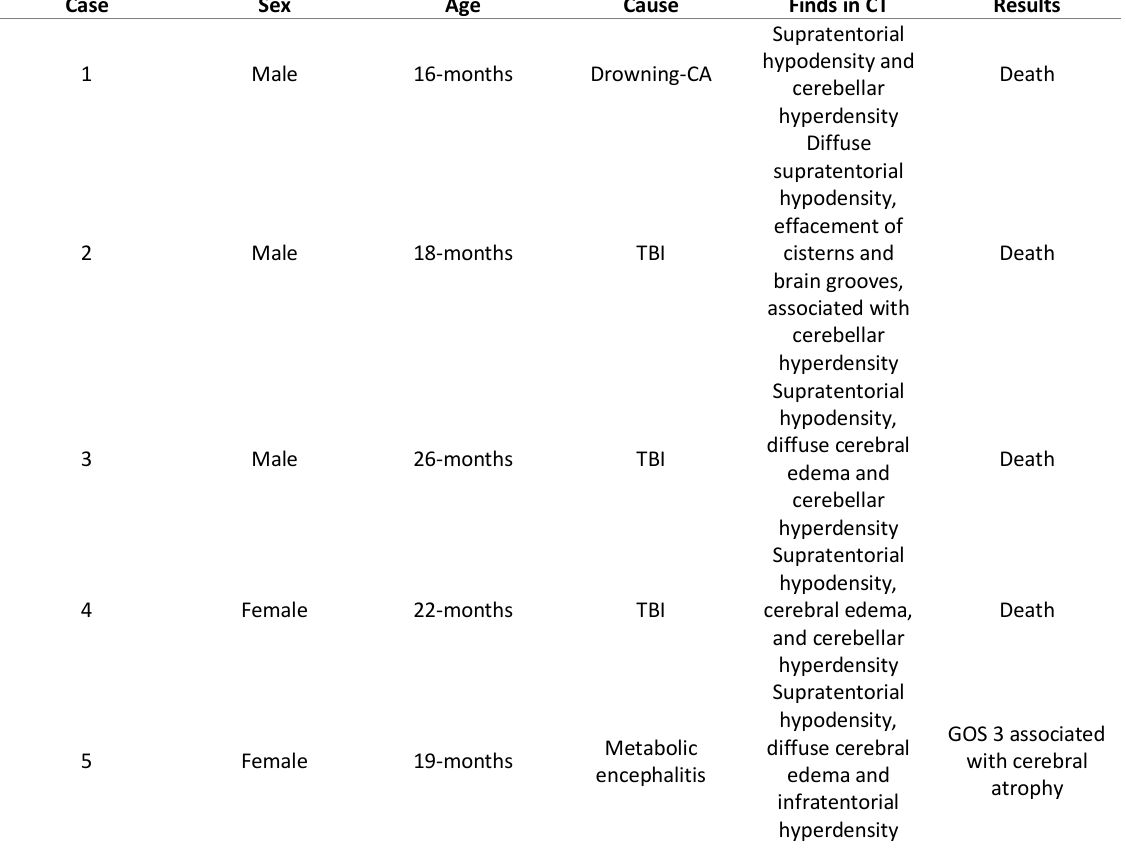
Table 1. Clinical-epidemiological characteristics of five patients with a white cerebellum